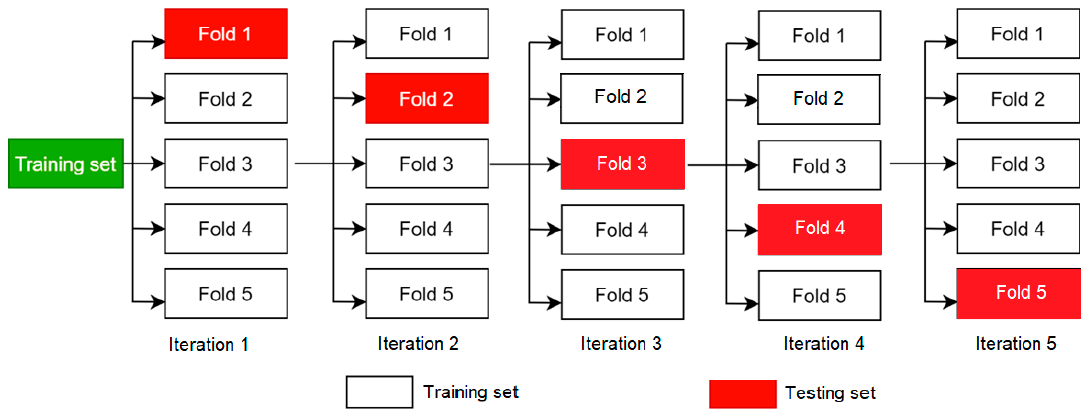
Figure 7. Flow chart of the 5-fold cross-validation technique.